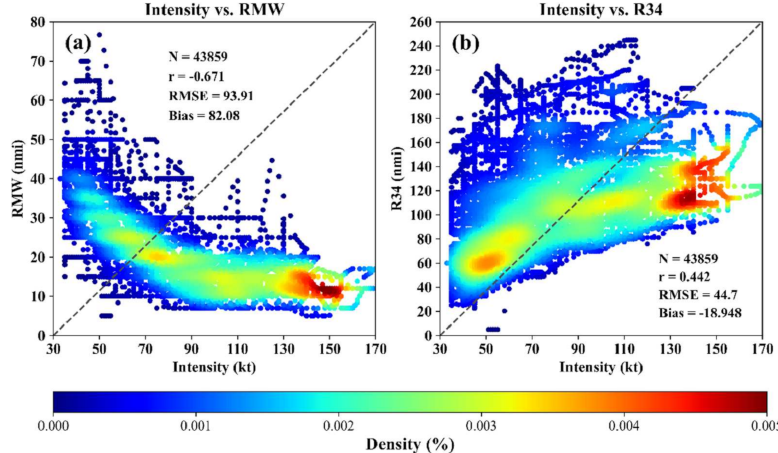
Figure 7. Relationship between TC intensity and ( a ) RMW and ( b ) R34. The different colors represent the density of the data estimated using the Gaussian kernel function. The number of samples (N), correlation coefficient, root mean square error (RMSE), and bias are also shown.